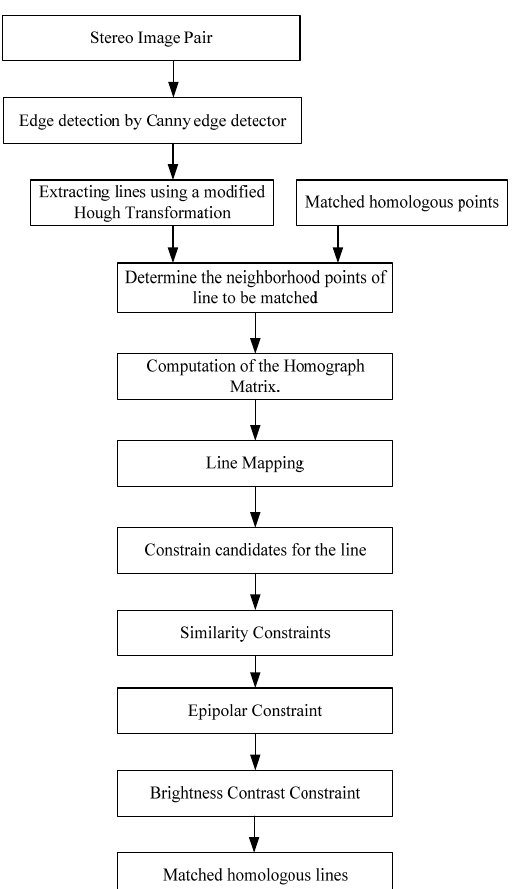
Figure 1. The flowchart of line matching based on